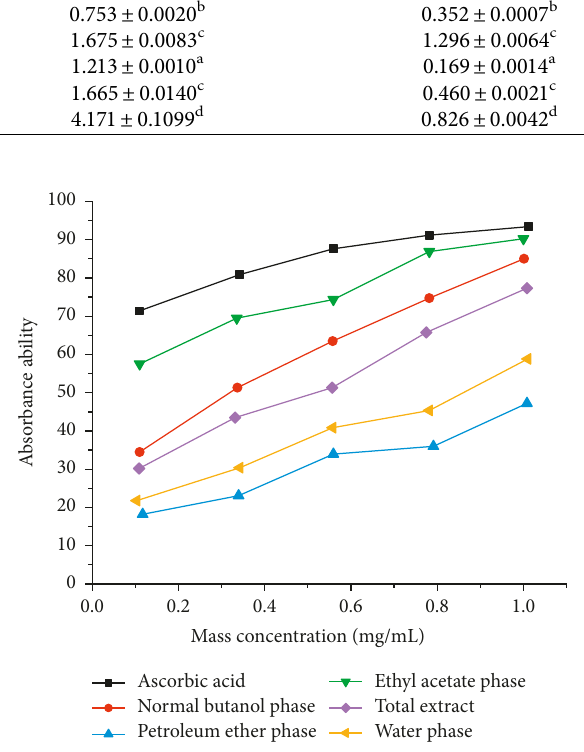
Table 1: Comparison of OH radical, ABTS + ∗ , DPPH, and scavenging ability of different extraction parts of Sophora japonica ethanol extract. Extraction site